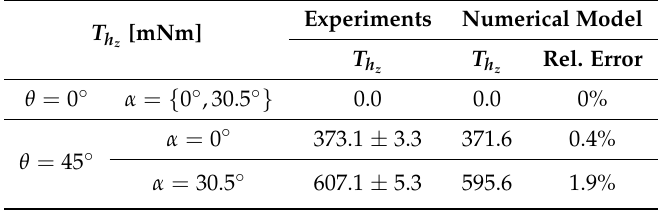
Table 1. Torque values comparison between numerical and experimental results. T h z